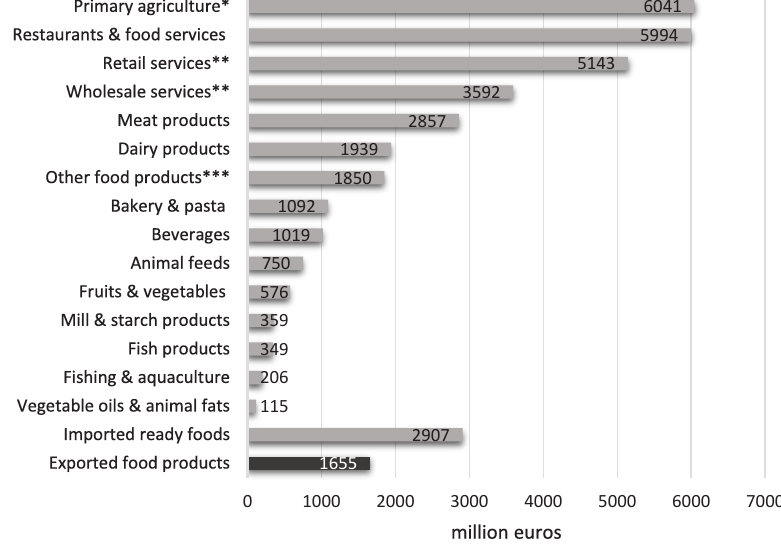
Fig. 3. Total output from the Finnish food and service sectors (€31.9 billion, including exported food products) with the total value of exported food products (€1.7 billion) and imported ready- to-eat foods (€2.9 billion) in